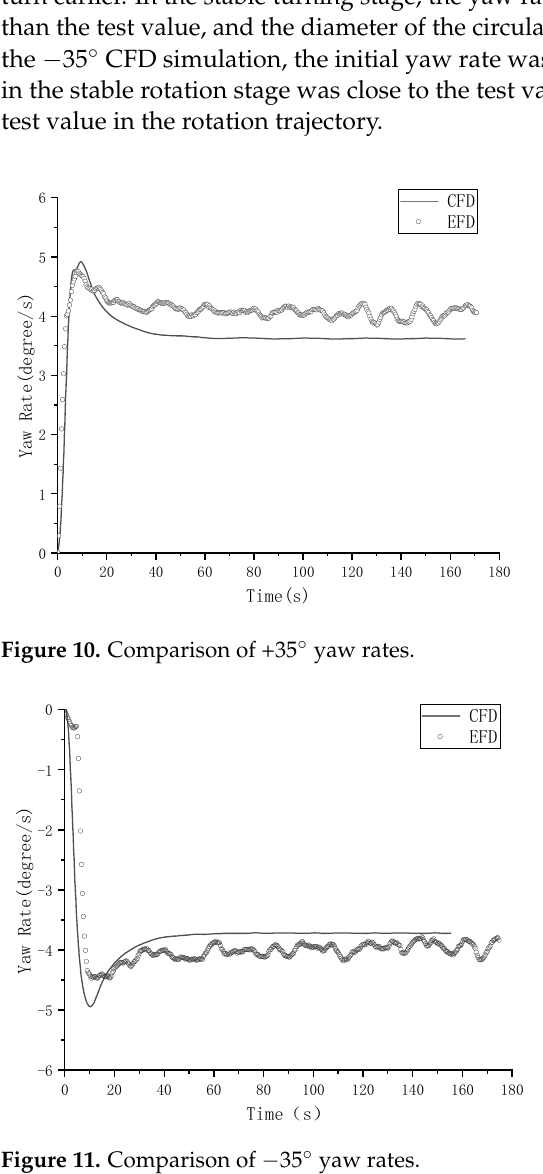
Figure 11. Comparison of − 35° yaw rates.